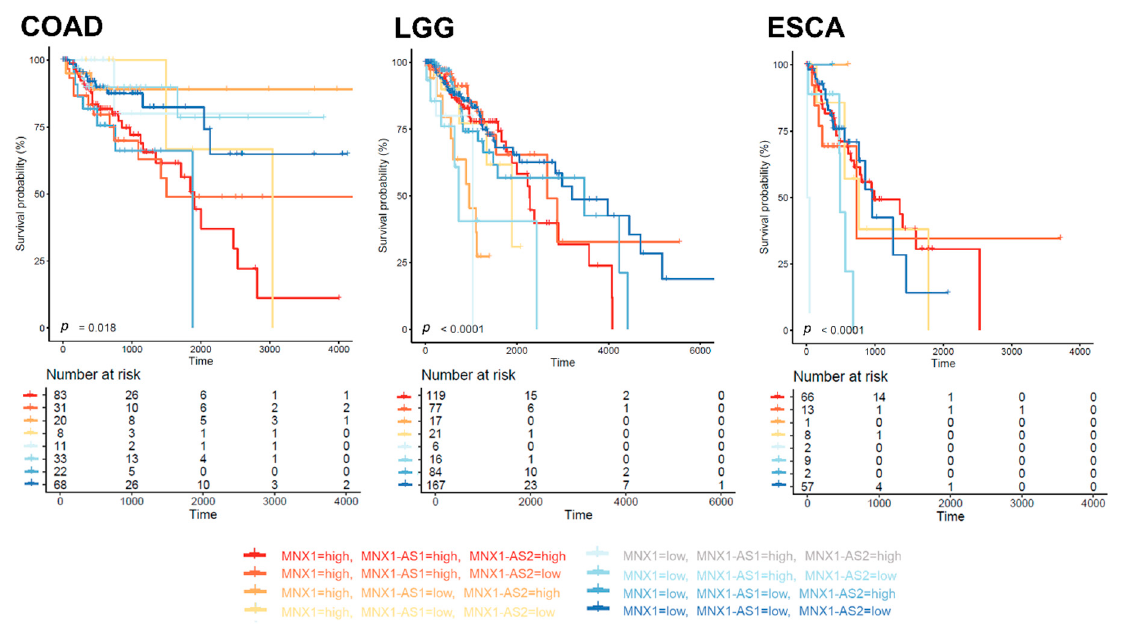
Figure 8. Combinatorial survival analysis of MNX1 , MNX1-AS1 , and MNX1 - AS2 expressions. Kaplan– Meier plots of OS in COAD, LGG, and ESCA with patients stratified according to expression levels.